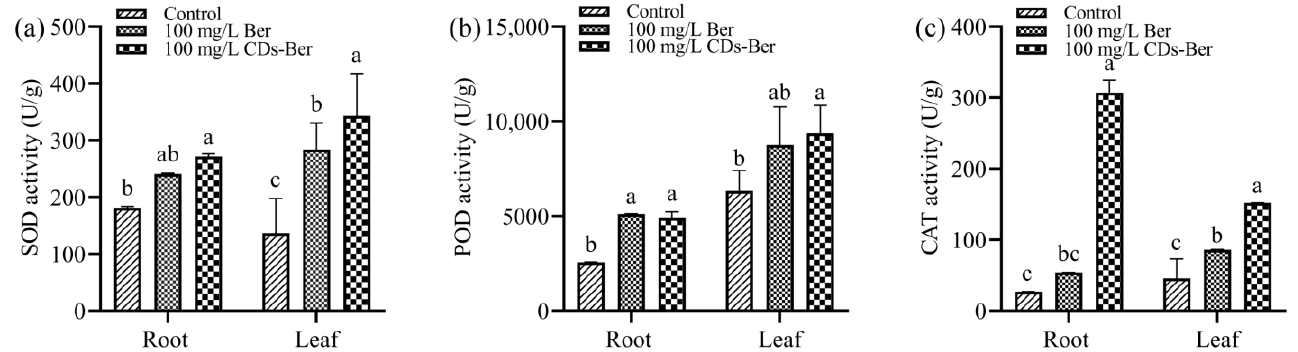
Figure 7. Effect of berberine and CDs-Ber treatment on ( a ) SOD activity, ( b ) POD activity, and ( c ) CAT activity of Echinochloa crus-galli (concentration of berberine and CDs-Ber is 100mg/L; control is deionized water). Note: data are presented as mean ± SD ( n = 3). Comparison within the group, different letters indicate significant differences, the same letter indicates no significant difference ( p < 0.05, LSD test).